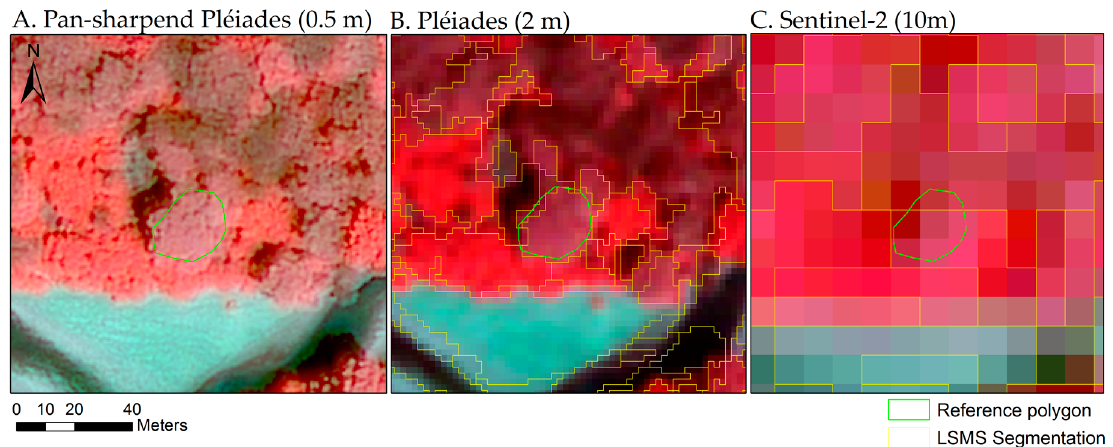
Figure 4. Comparison of false color data with segmentation results of the Large Scale Mean Shift algorithm (in yellow). A digitized tree crown (ingreen) is also shown: ( A ) pan-sharpened Pléiades data; ( B ) original Pléiades data; and ( C ) Sentinel-2 data. The parameter selection used for the LSMS segmentation is displayed in Table 4.